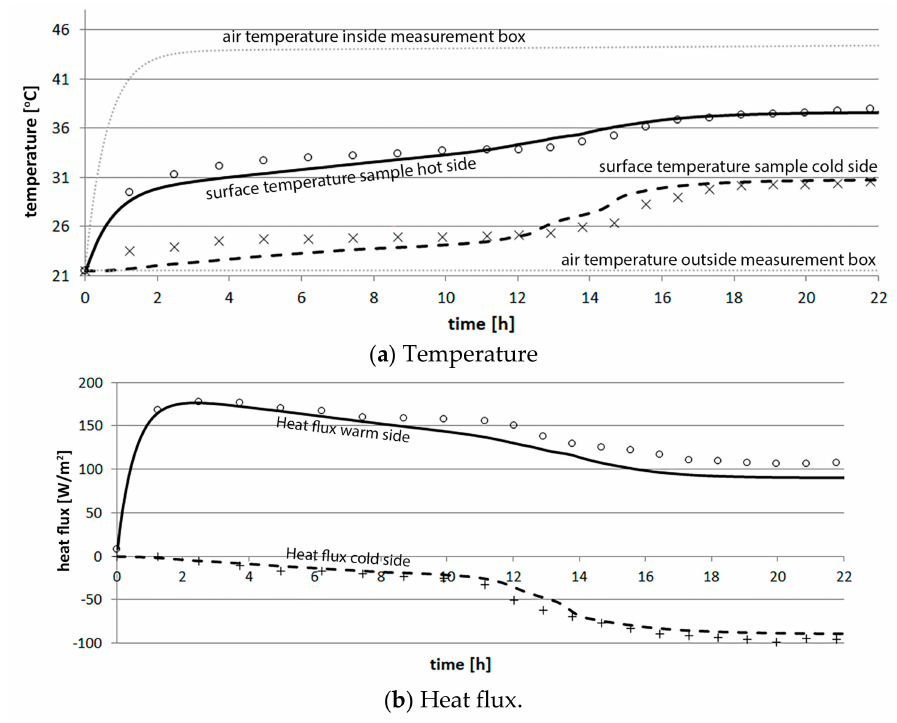
Figure 8. Results of the validation of the simulation model by physical